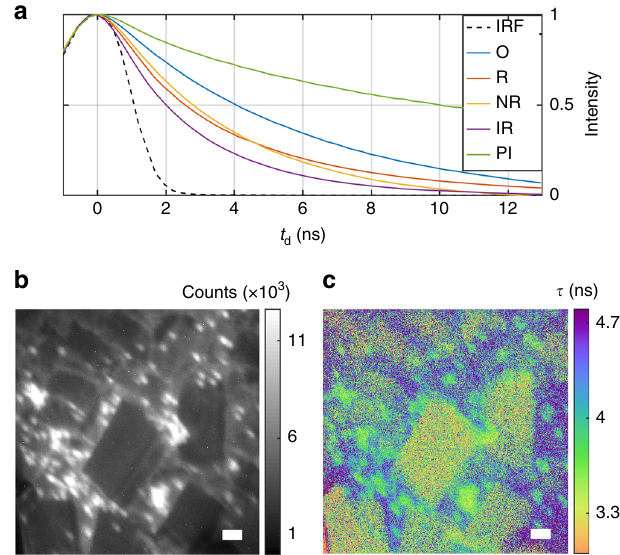
Fig. 2 Multi-label FLIM. a Direct measurement of fl uorescence decays obtained by sweeping gate delay time t d for orange (O, 4.9 ns), red (R, 3.4 ns), nile red (NR, ~3.1 ns), infrared (IR, 2.3 ns) and propidium iodide (PI, 14 ns) beads. Fitted decay constants τ are given. The measured Gaussian instrument response function (IRF) is plotted in black. b Intensity image of a three-label wide- fi eld sample of orange, nile red, and infrared beads (labels strongly overlap spatially). c Lifetime image reveals spatial distribution of the labels. Lifetime is measured by fi tting the decay traces at each pixel (scale bars 10 μ